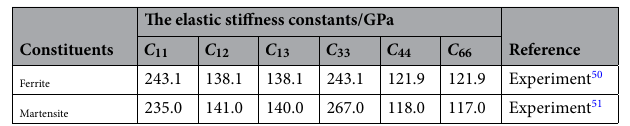
Table 4. Elastic stiffness constants of ferrite and